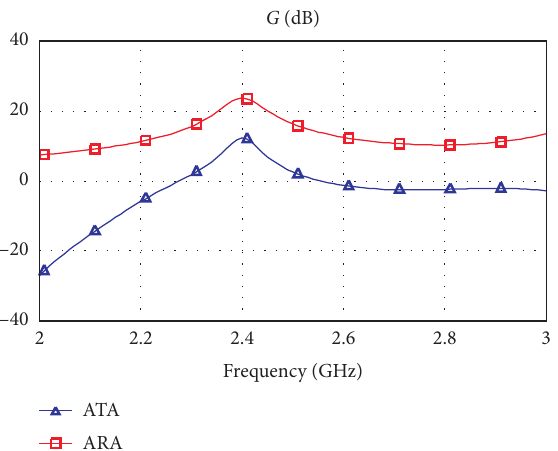
Figure 10: Transducer power gains of the active antennas two-port networks models as functions of frequency.